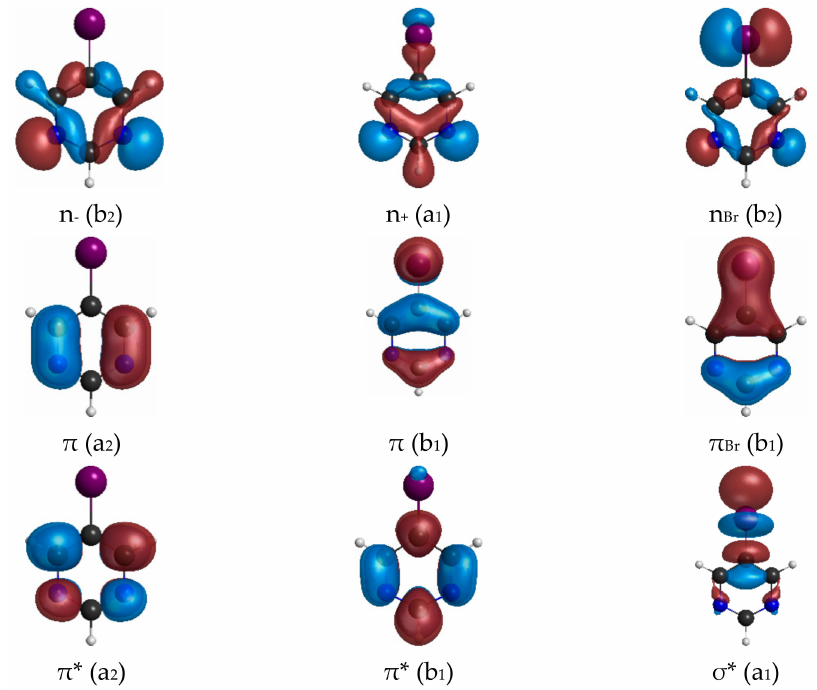
Figure 3. Typical hole and particle natural transition orbitals for the electronic transitions of